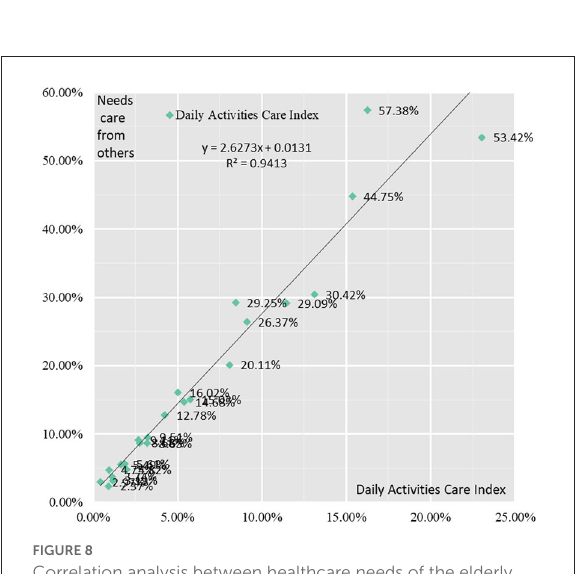
FIGURE8 Correlation analysis between healthcare needs of the elderly and the need for daily care